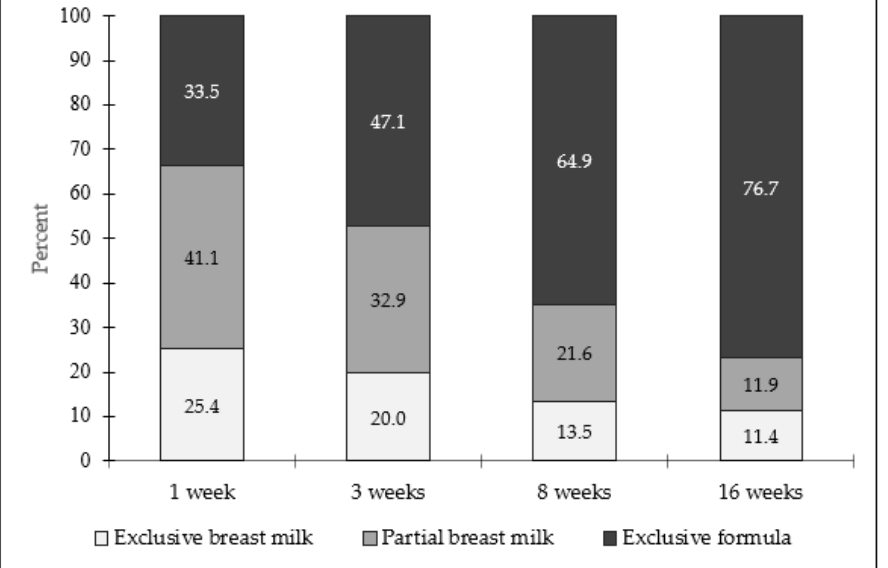
Figure 1. Mothers’ infant feeding at ages 1, 3, 8, and 16 weeks ( n = 185). Infant feeding defined as “exclusive breast milk” (feeding breast milk only), “partial breast milk” (feeding a combination of breast milk and infant formula), and “exclusive infant formula” (feeding infant formula only).